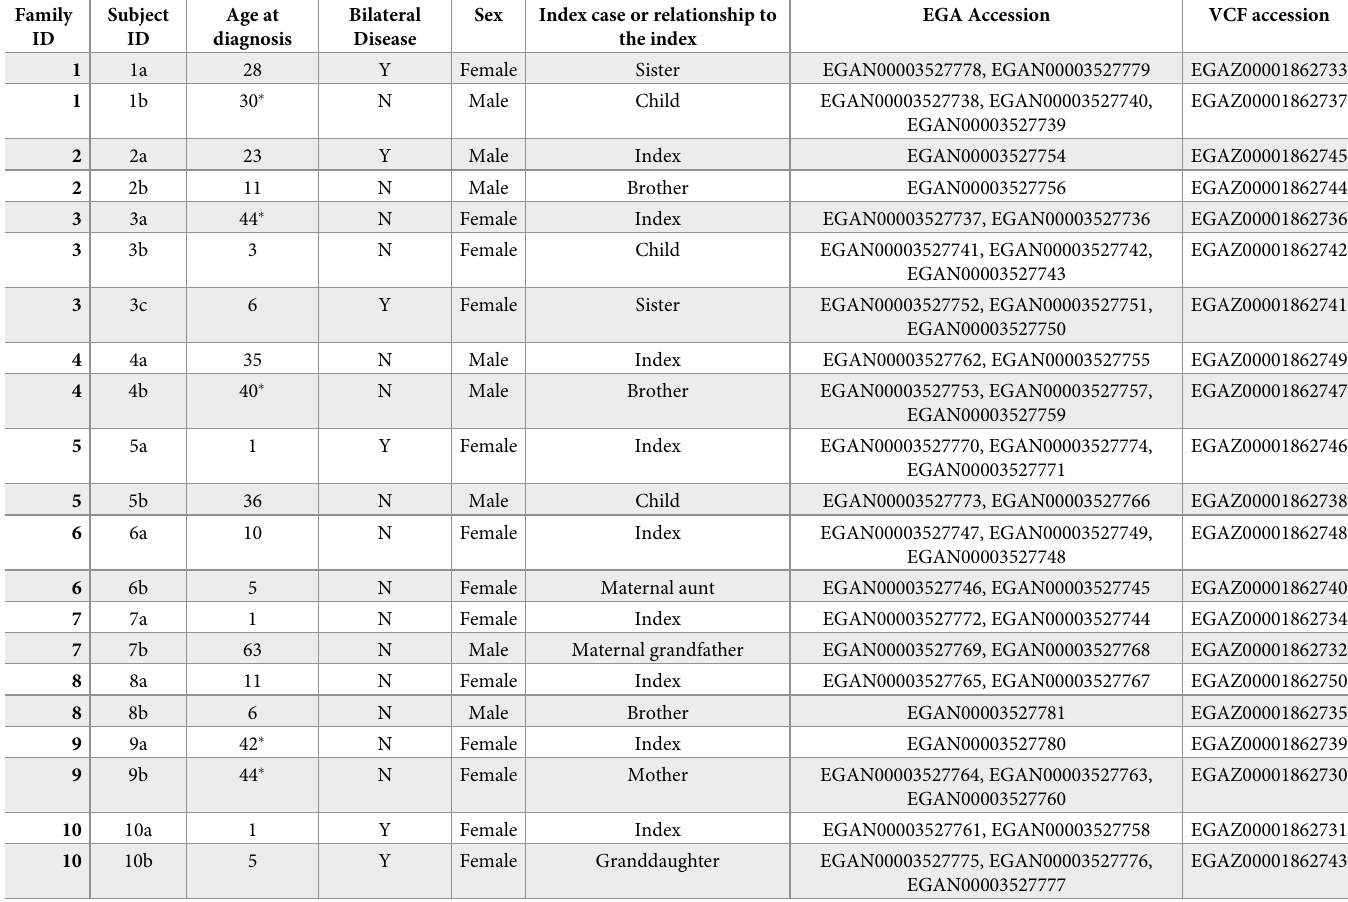
Table 1. Study participants. Participants within families share numeric IDs. Age of diagnosis is given unless unavailable, where age at first surgery � is given instead. Cho- lesteatoma in both ears is described as bilateral disease (Y = yes) while disease in one ear is described as not bilateral disease (N = no). Familial relationships are described with respect to the index case. Sequencing data and VCFs were uploaded for each participant to the EGA data repository (EGAD00001008671;